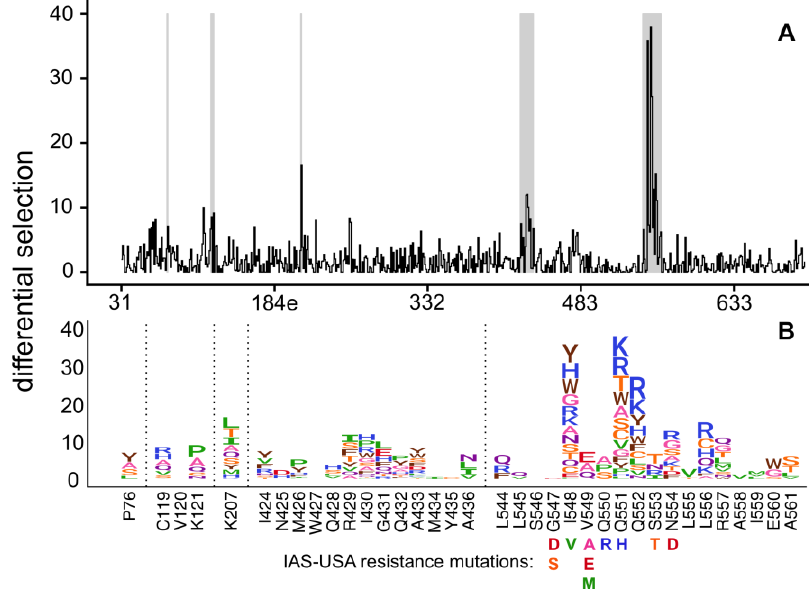
Figure 1. A complete map of enfuvirtide resistance. ( A ) The positive site differential selection is plotted across the mutagenized portion of Env. ( B ) The mutation-level resistance profile for regions of interest (highlighted in grey in (A)). See Figure S2 and File S2 for the entire env -wide, mutation-level resistance profile. The height of each amino acid is proportional to its differential selection, which is the logarithm of the relative enrichment of that mutation in the enfuvirtide-selected condition relative to the non-selected control. All mutations from the 2017 IAS-USA enfuvirtide resistance mutations list [14] are labeled below their site.